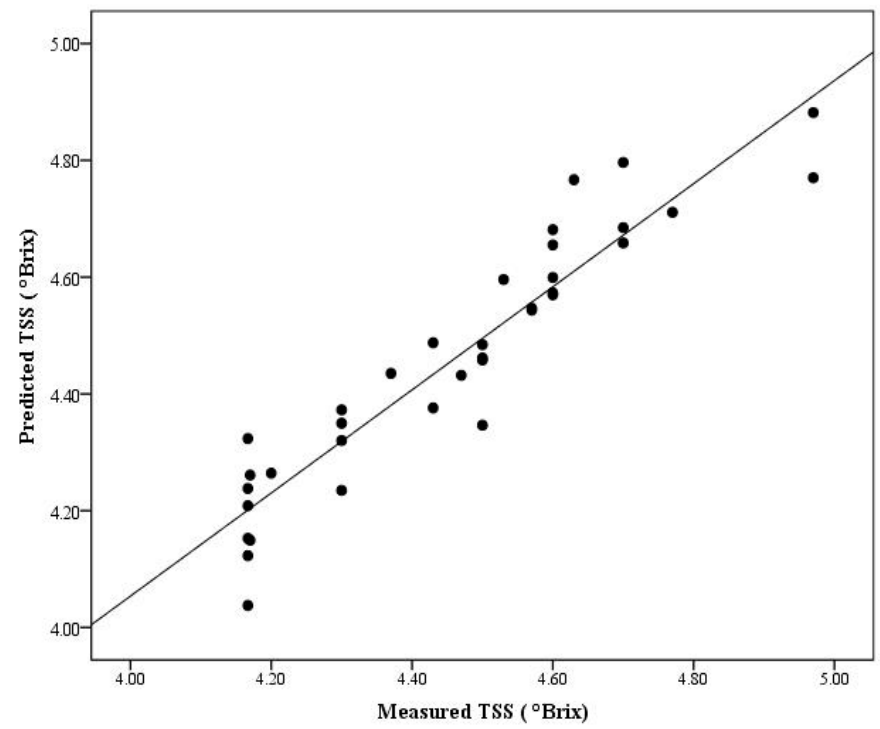
Figure 11. Results for the prediction of TSS values based on linear regression models.